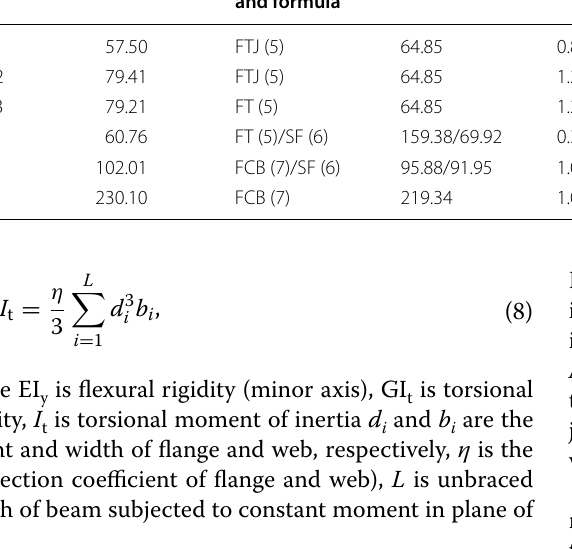
Table 4 Comparison between calculated values and test results Beam